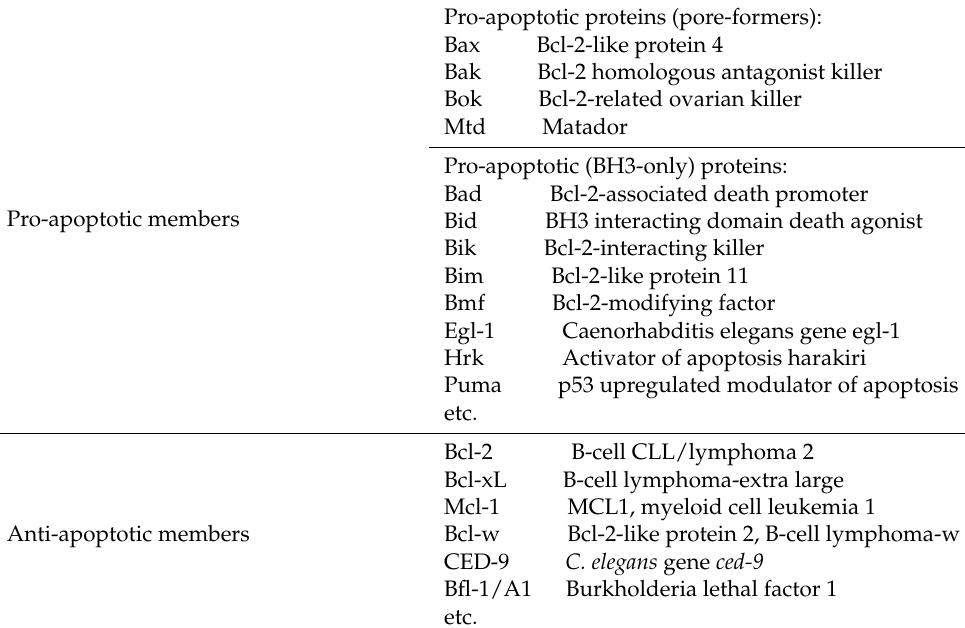
Table 1. Bcl-2 family pro-and anti-apoptotic